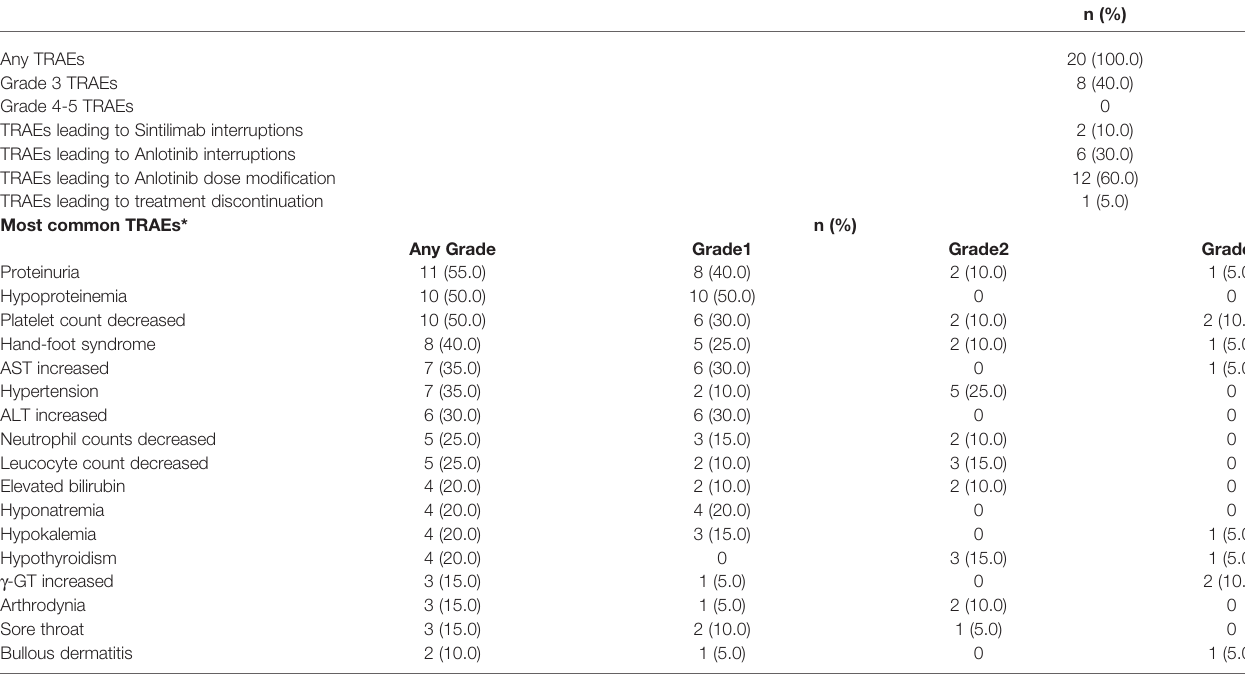
TABLE 2 | Treatment-related adverse events (TRAEs) in the safety set (N=20).